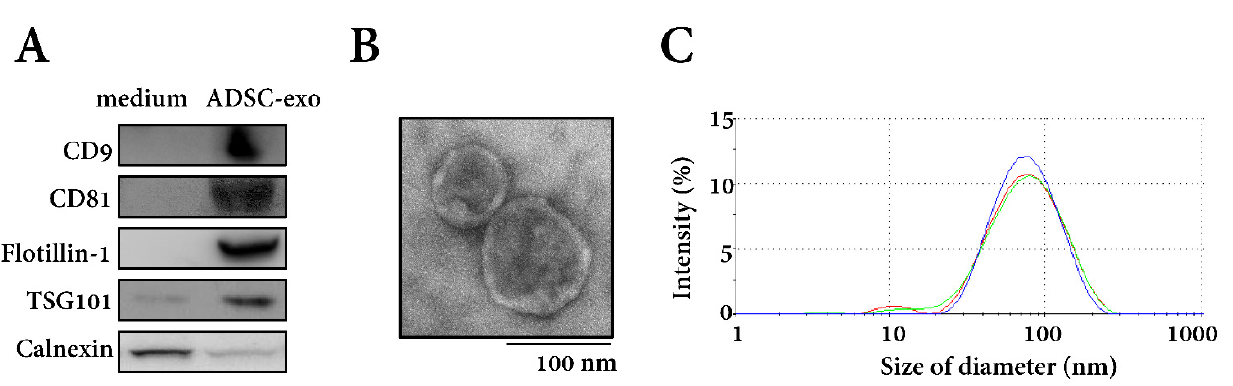
Figure 1. Characterization of isolated exosomes by ( A ) Western blotting for exosomal surface markers, ( B ) transmission electron microscope analyses, and ( C ) the measurement of particle diameter by dynamic light scattering. ADSC-exo, exosomes secreted by adipose-derived stem cells